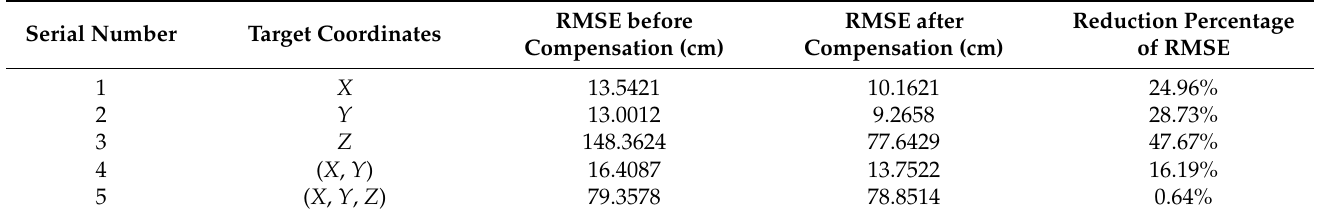
Table 4. RMSE before and after compensation of ranging errors with signal interference.